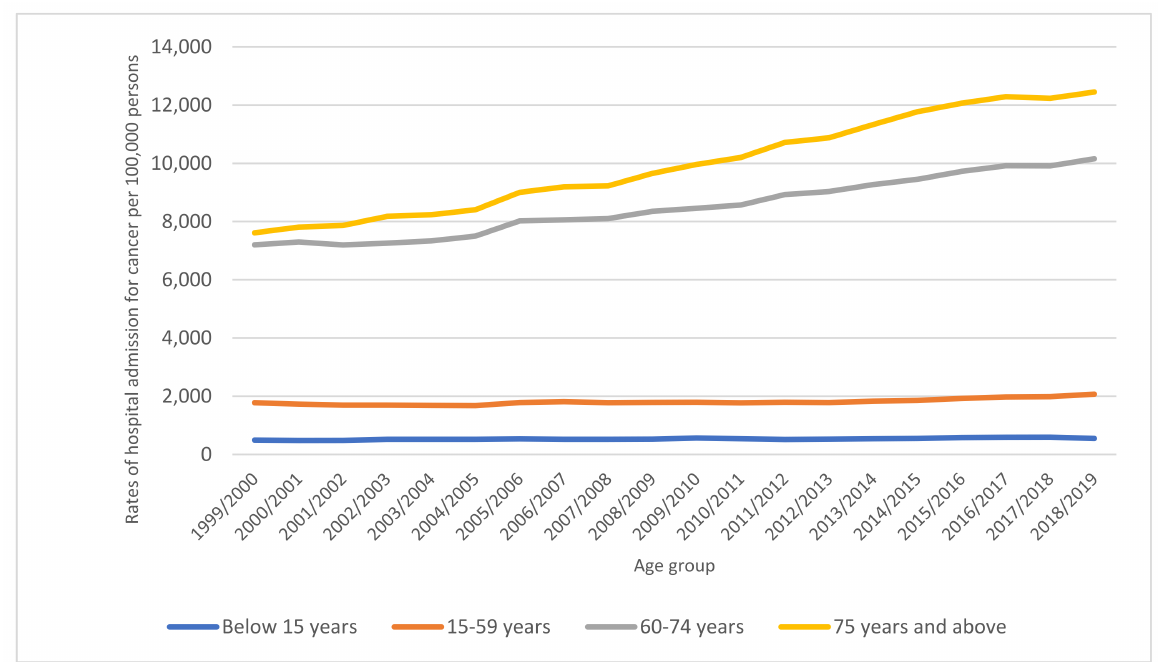
Figure 1. Hospital admission rates due to neoplasms in England and Wales were stratified by type between 1999 and 2019.